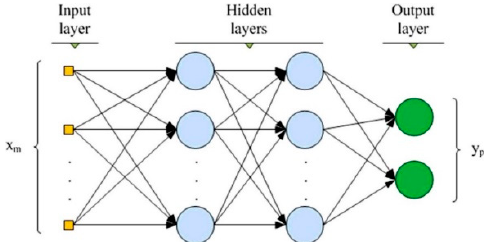
Figure 1. Schematics of multilayer perceptron neural networks [30].